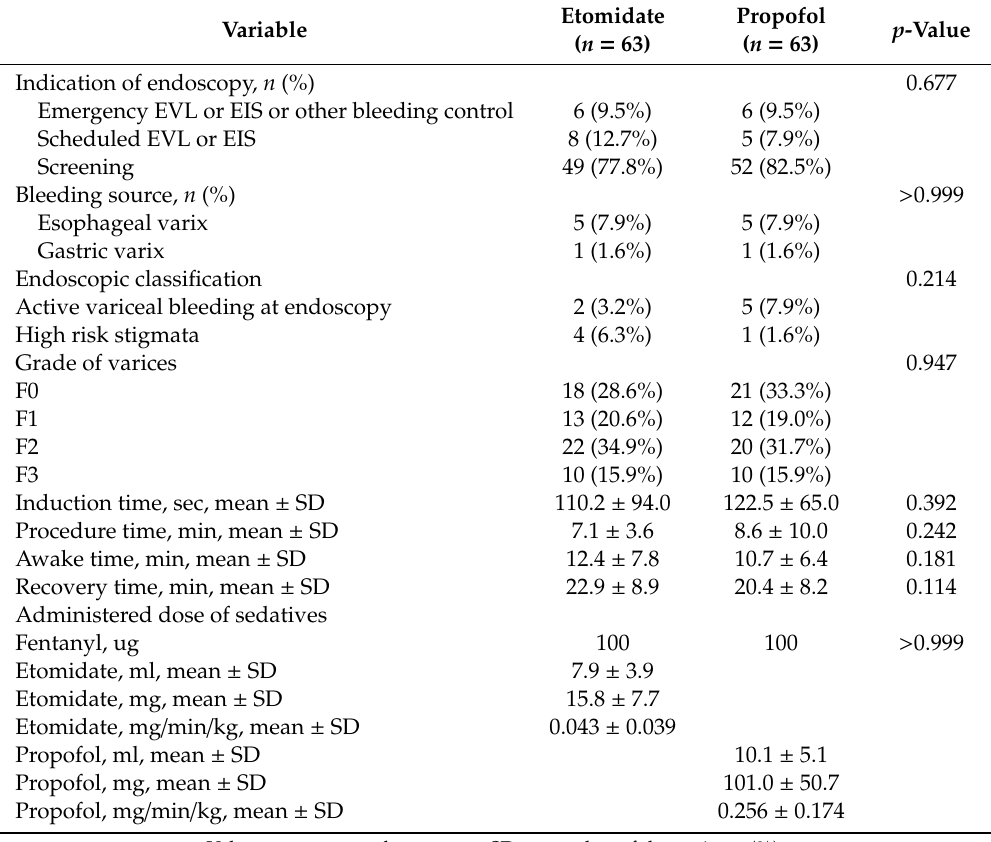
Table 2. Procedure and sedation-related